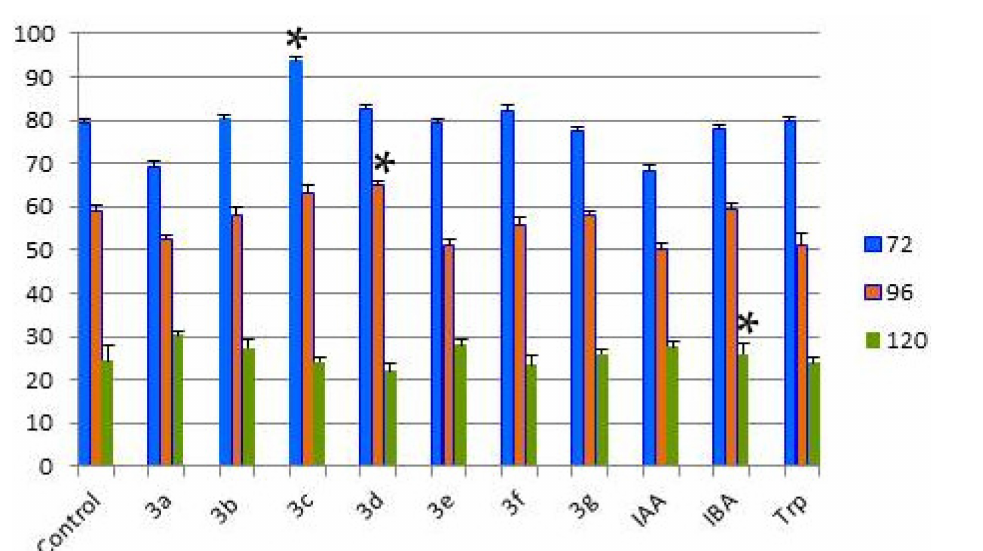
Figure 2. The relative water content wheat shoots treated with hybrid compounds 3 under water stress. *—traditional designations for statistically significant